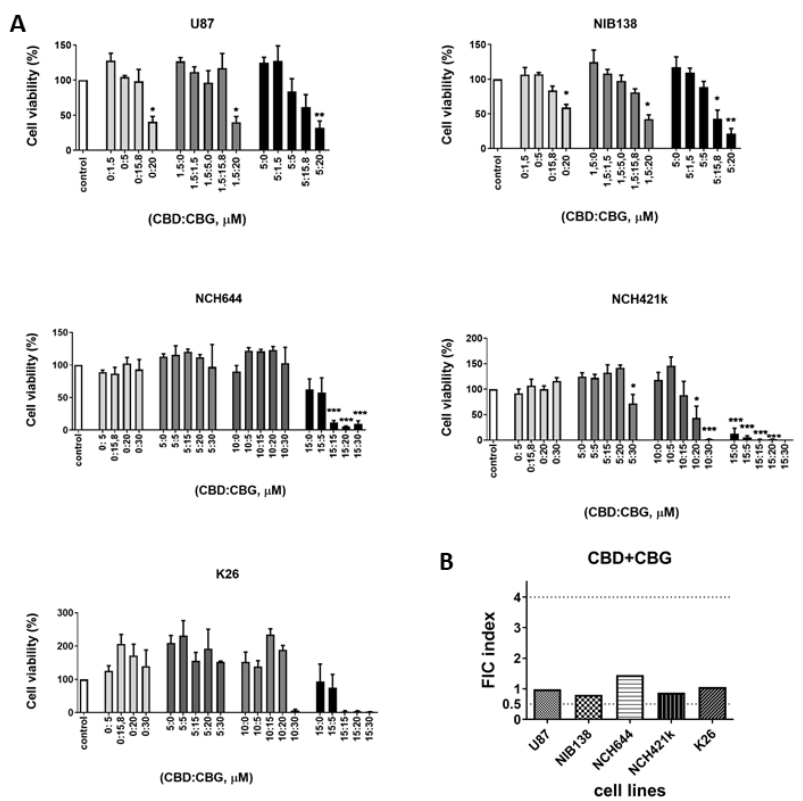
Figure 5. The effects of combined CBD and CBG on the viability of GB cells and GSCs. ( A ) The efficacy of combined CBD and CBG treatment was tested on the following cell lines: U87, patient-derived NIB138, NCH644, NCH421k, and K26. The viability was determined by MTT/MTS assays after 48 h of single treatment as described in Materials and Methods (Section 2.5). White bars represent the untreated controls, and the grey and black bars represent treatments with fixed concentrations of CBD (1.5 and 5 μM for GB lines and 5, 10, and 15 μM for GSC lines); increasing concentrations of CBG (0–20 μM) were added. Error bars represent mean ± S.E.M. Statistical analyses were performed using GraphPad Prism software, using one-way ANOVA (* p < 0.05, ** p < 0.01, *** p < 0.001). Three biological and three technical repeats were performed. Vehicle comprised ≤ 0.4% ( v / v ) DMSO for CBD and 0.24% (v/v) ethanol for CBG. ( B ) The combination responses were determined as the factor of inhibitory concentration (FIC) values between CBD and CBG on GB cells and GSCs. FIC values were calculated from combined CBD:CBG treatment that produced half-maximal effects on the viability of GB cells and GSCs when CBD was fixed at 1.5 and 5 μM for the U87, and NIB138 lines and at 5, 10, and 15 μM for GSCs. Synergy was defined as FIC < 0.5, additivity was defined as 0.5 < FIC < 4, and antagonism was defined as FIC > 4.